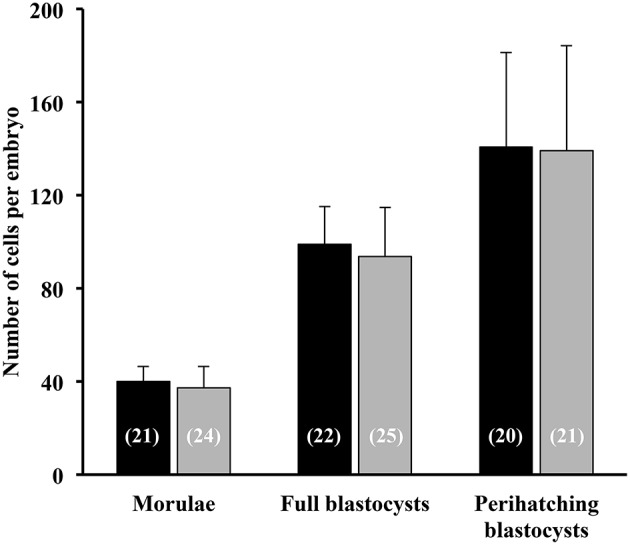
Total cell number of morulae, full blastocysts and peri-hatching blastocysts recovered 6 days after the postcervical infusion of heterologous seminal plasma (SP; black bars; N = 16 sows) or BTS (Control; gray bars; N = 18 sows) prior to insemination. Numbers in parentheses are the number of embryos counted for each stage.